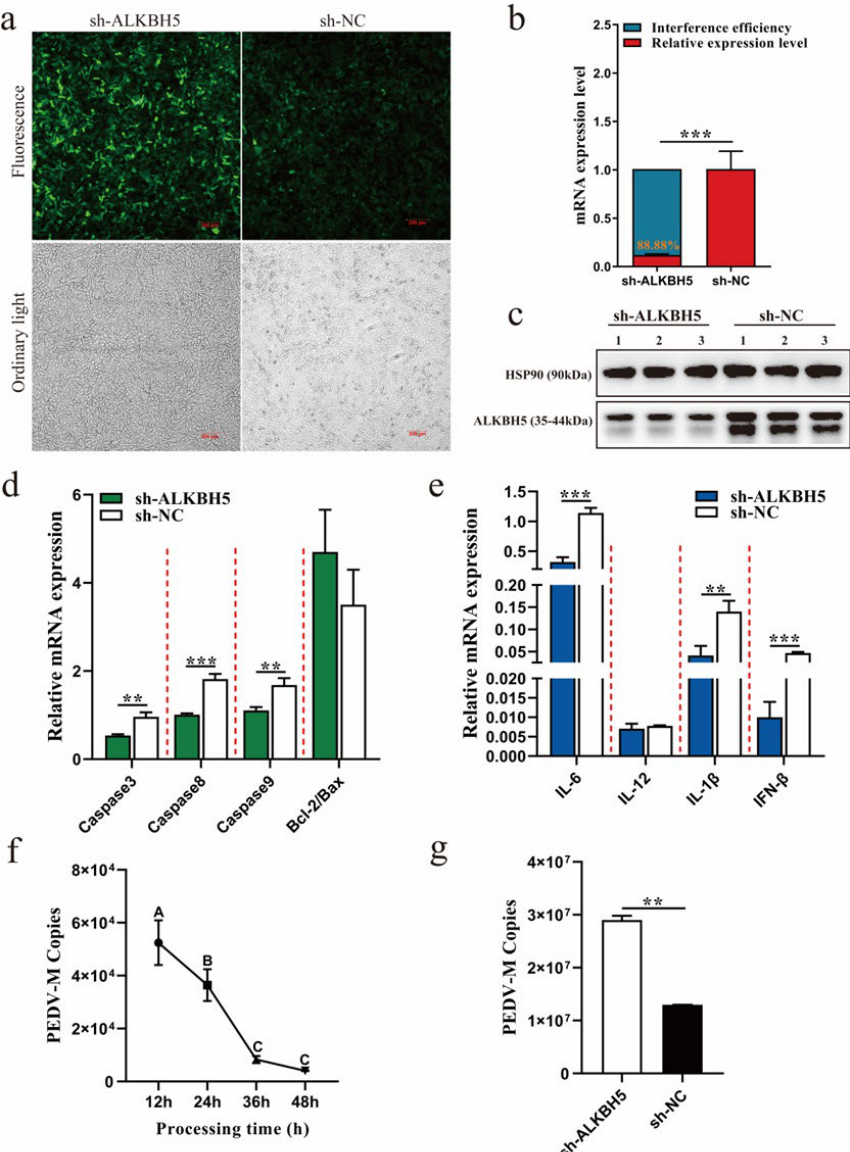
Figure 3. Disruption of ALKBH5 expression by RNAi increases PEDV infection capacity. ( a ) Expres- sion of GFP in lentivirus-transfected 3D4/21 cells screened by puromycin. ( b ) qPCR was performed to detect ALKBH5 gene interference efficiency. sh-ALKBH5: lentivirus-transfected LV3-ALKBH5 group. sh-NC: lentivirus-transfected LV3-NC group. ( c ) The interference efficiency of ALKBH5 was detected by Western blotting. ( d ) Effect of interfering with the ALKBH5 gene, regarding the expression of apoptosis-related genes in 3D4/21 cells. ( e ) Interfering with the effect of the ALKBH5 gene on the expression of inflammation-related genes in 3D4/21 cells. ( f ) Copy number of PEDV-infected 3D4/21 cells at different time periods. ( g ) Effect of ALKBH5 gene interference on PEDV copy number. At least three biological replicates are used for each group. Data are presented as the mean ± SD; ** p < 0.01, *** p < 0.001.